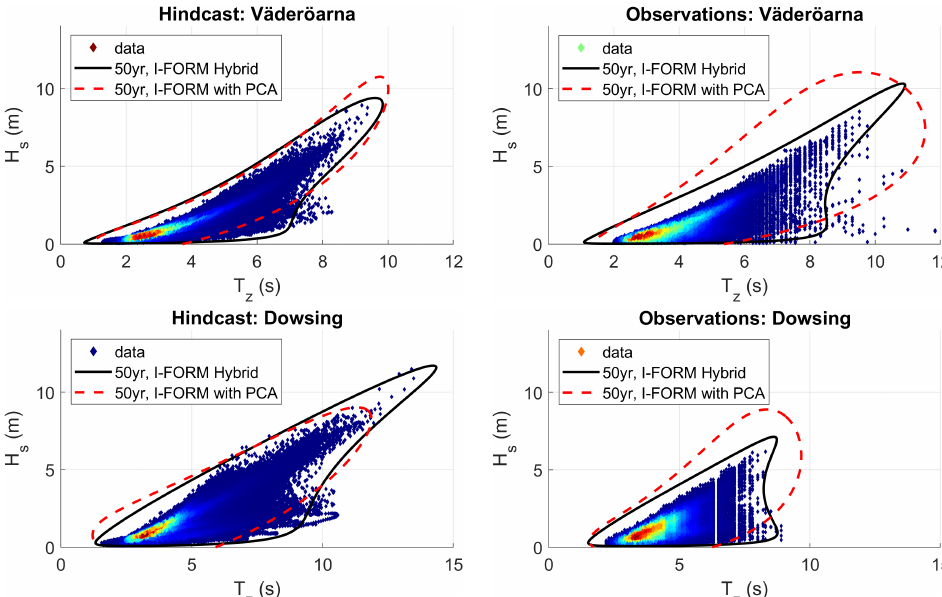
Figure 11. Comparing 50-year environmental contours for two methods: (1) I-FORM with a hybrid fit for H s , without infla- tion (black solid line) and (2) I-FORM with principal component analysis (PCA) (red dashed